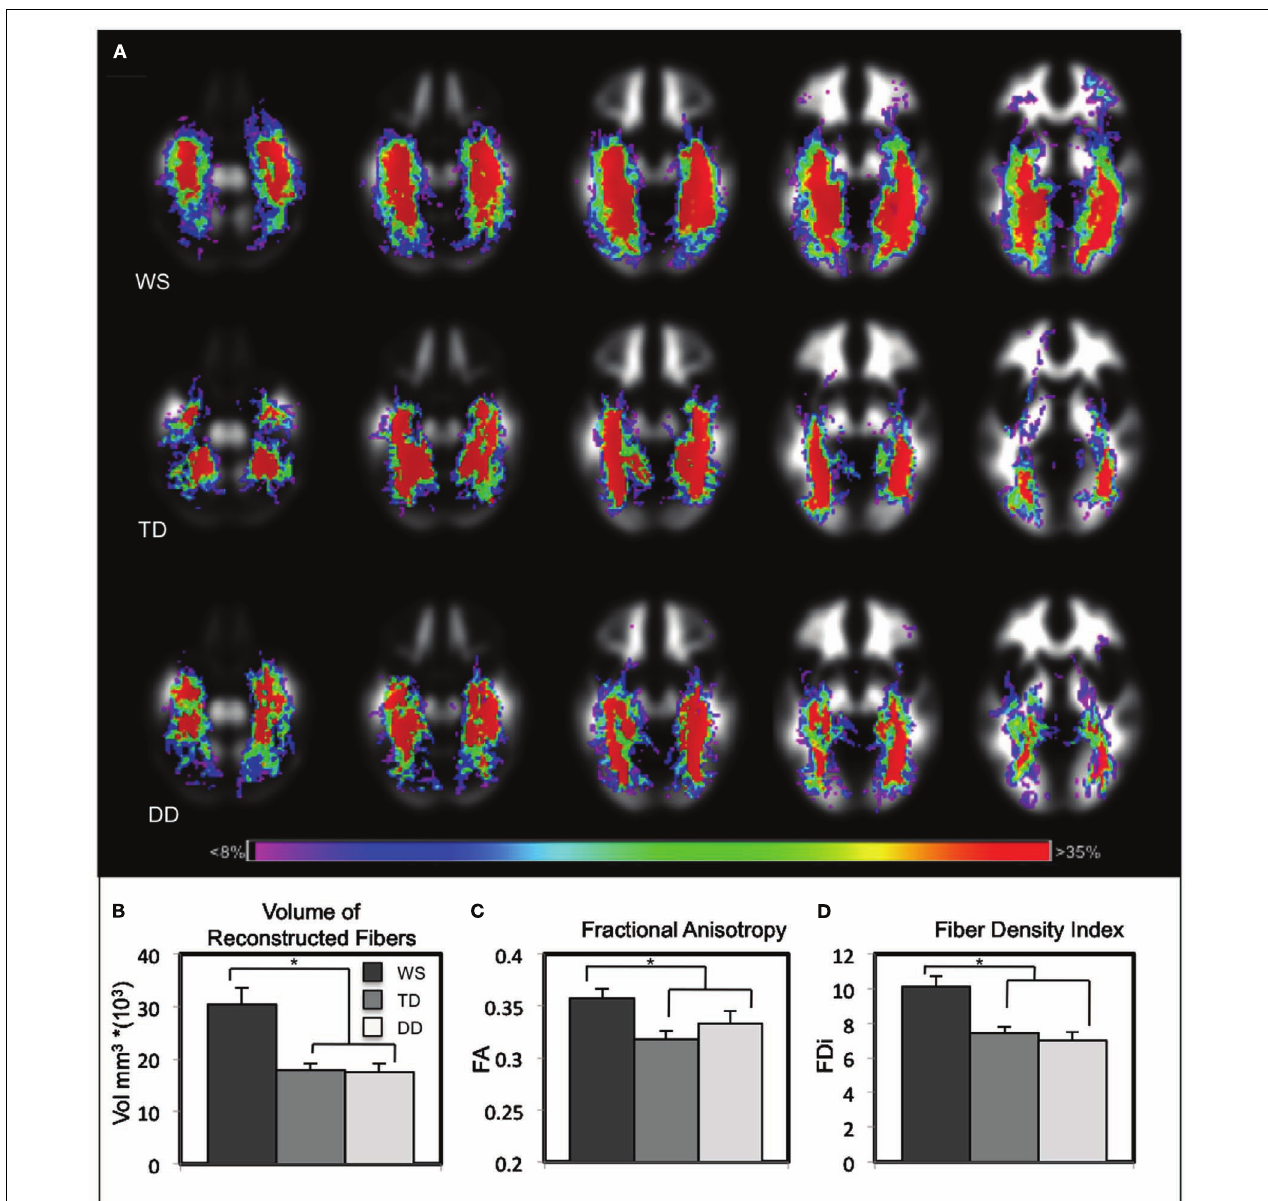
reconstructed fibers] and micro- [ (C) fractional anisotropy and (D) fiber density index] for fibers projecting through the fusiform gyrus inWS,TD and DD participants.Vol mm 3 , volume in millimeters; FA, fractional anisotropy; FDi, fiber density index; * p < 0.05. Error bars represent standard error from the mean. Adapted from Haas et al. (2012) Genes, Brain, and